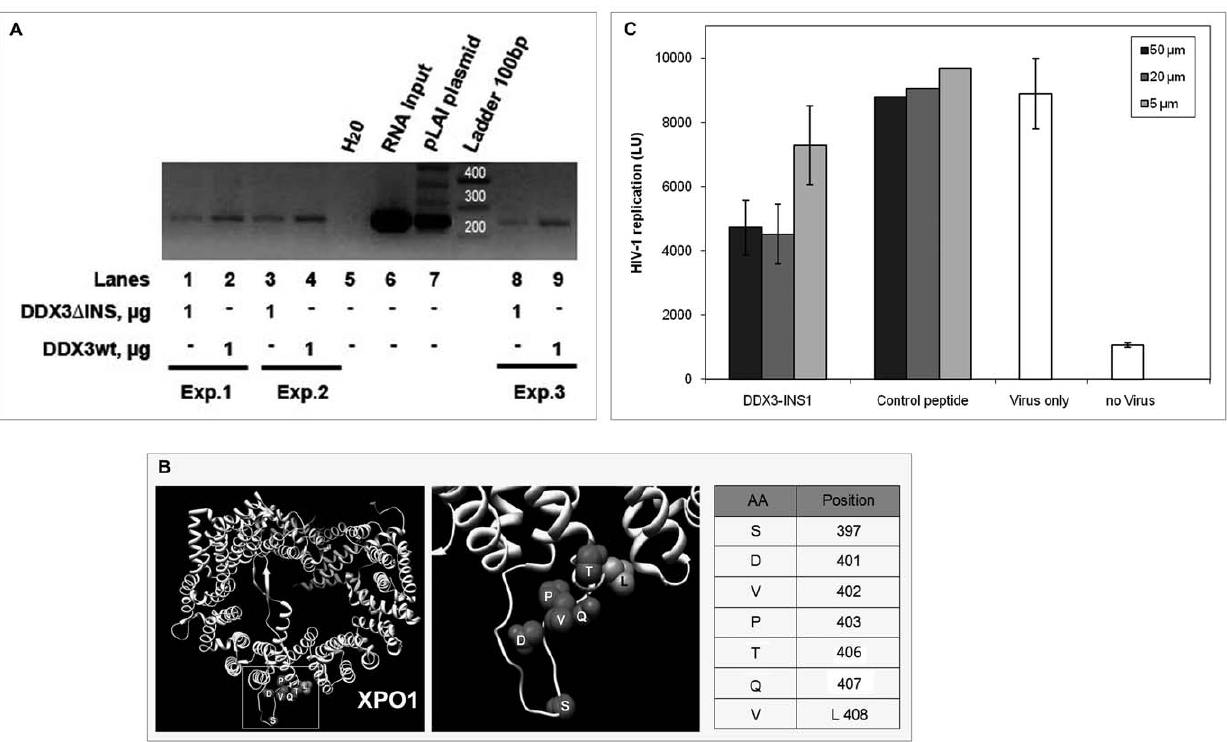
Figure 7. The DDX3 insert is functionally implicated in the HIV-1 cofactor activity of DDX3 . HIV genomic RNA pull down experiments with purified DDX3wt and DDX3 D INS proteins. Bound HIV RNA was detected by RT-PCR with gag -specific primers in three independent experiments (lanes 1 and 2; lanes 3 and 4; lanes 8 and 9). Lanes 6 and 7 correspond to RT-PCR fragments of input viral RNA and PCR of the HIV-1 pLai plasmid, respectively; lane 5 is the negative PCR control. B . Peptide DDX3-INS1 selected with the DDX3 insertion by phage display shows homology to XPO1. The crystal structure of XPO1 (DOI:10.2210/pdb3gb8/pdb) is shown and amino acids identical to the peptide sequence are represented as spheres. The corresponding positions are indicated on the right side of the panel, along with the conservative substitution V408L. C . Antiviral activity of the selected peptide DDX3-INS1 fused to a protein transduction domain. Peptides DDX3-INS1 and a control peptide were transduced into HelaP4 cells after infection with HIV-1Lai and virus in supernatants was quantified on Tzm-bl cells by luminometry after 44 hours. Bars represent the mean of 3 independent experiments and error bars indicate SD. For the control peptide, one representative experiment is shown. DNA oligonucleotide sequences were:d18mer_FAM:5 9 CT-